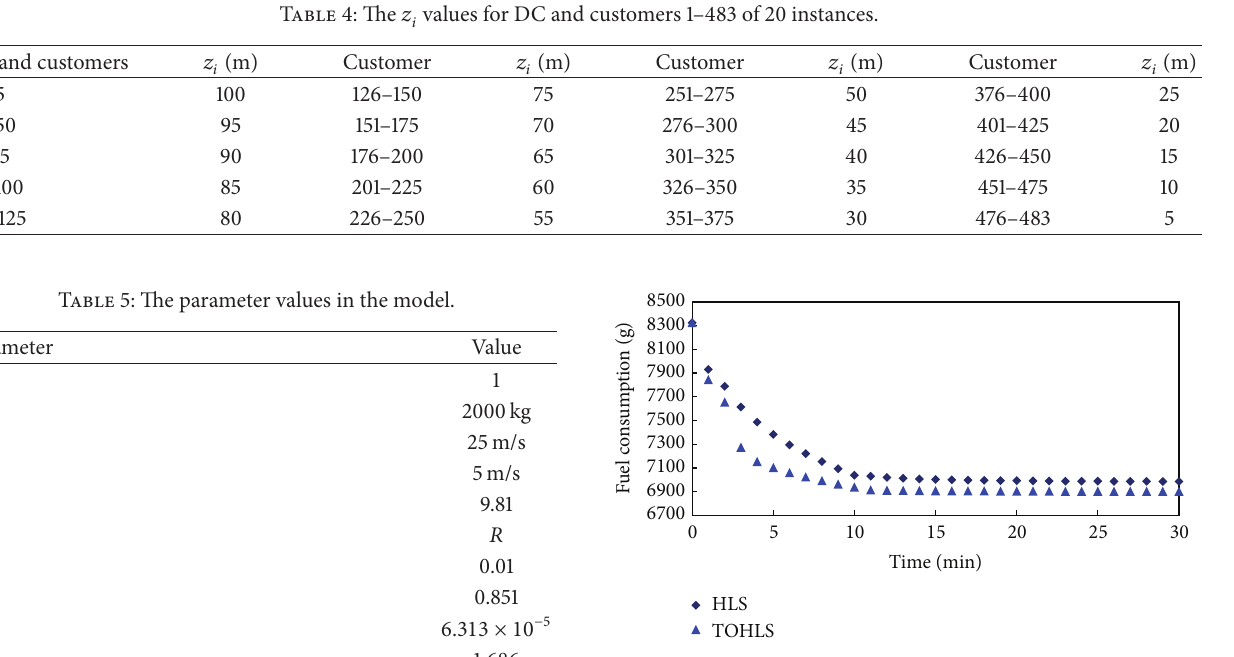
algorithm as the relative percentages of the results of hybrid